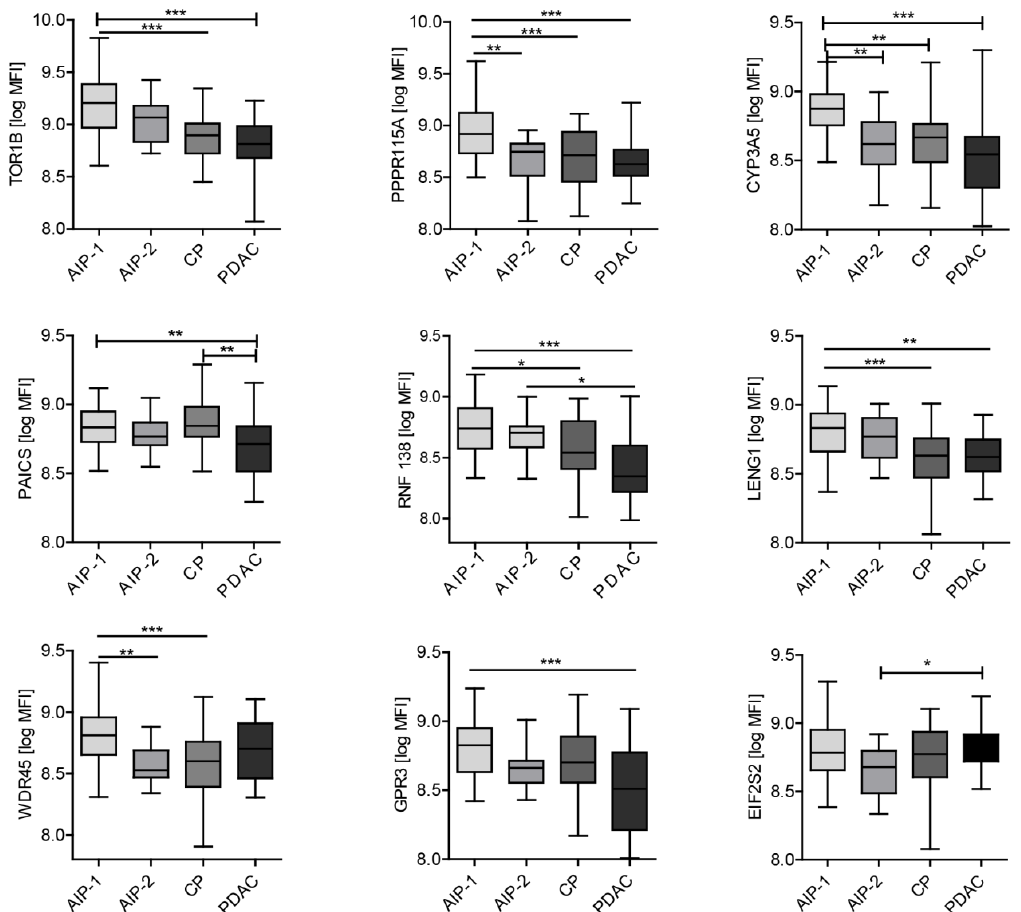
Figure 3. Comparison of antibody reactivity for serum antibodies (MFI) to autoantigens between the different pancreatic diseases. Differences were considered statistically significant when the p ‐ value was less than 0.05 and are marked with an asterisk: * p < 0.05, ** p < 0.01 and *** p < 0.001. The models discriminating between PDAC and AIP-1 and AIP-2, respectively, yielded high AUC values of 0.940 and 0.925,